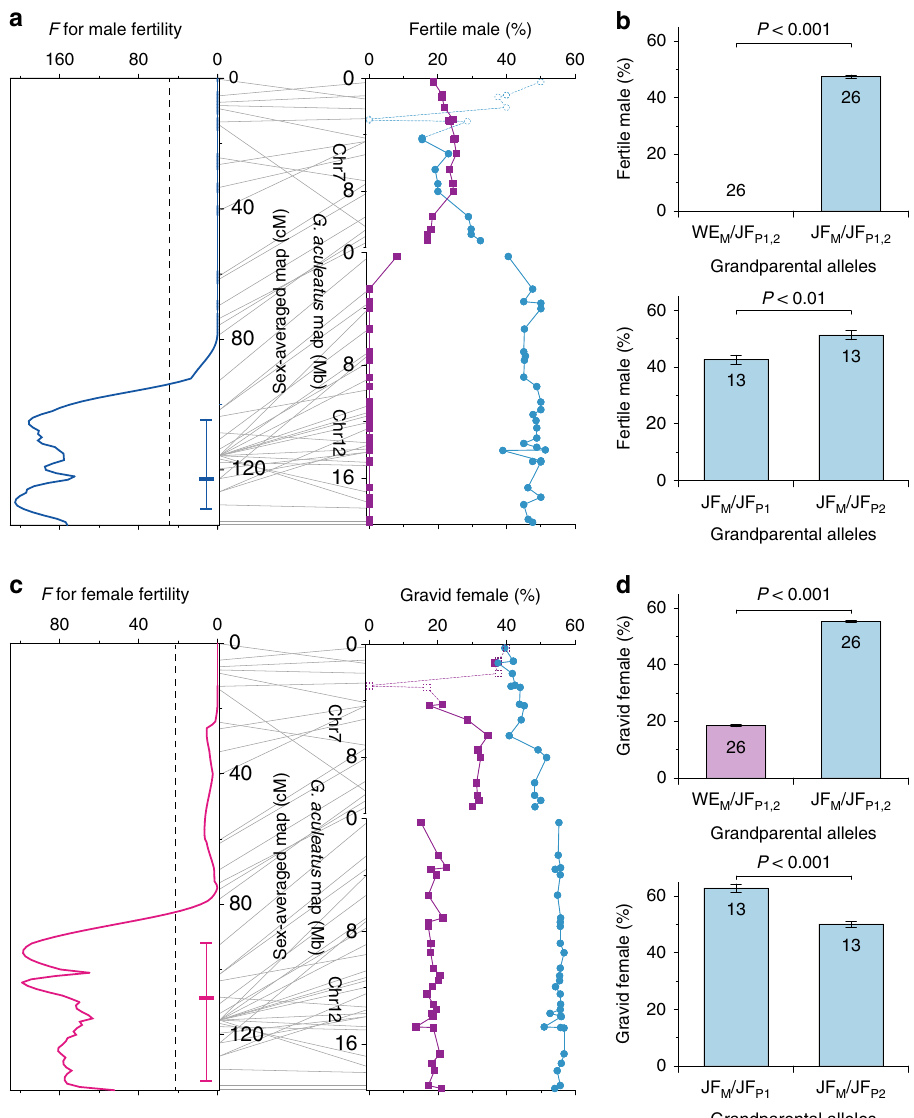
Fig. 5 QTL region for hybrid male and female fertility. a QTL analyses for male fertility (left) and the proportions of fertile males with different allelic combinations at each locus (right) in the backcross. b The proportions of fertile males with different allelic combinations in the inversion region (3.5 – 18.9 Mb of G. aculeatus Chr12). c QTL analyses for female fertility (left) and the proportions of gravid females with different allelic combinations at each locus (right) in the backcross. d The proportions of gravid females with different allelic combinations in the inversion region. In a , c , dashed lines in the graphs on the left represent statistically signi fi cant levels ( P = 0.05) of the F -value. The mean and 95% con fi dence interval of a QTL position are indicated to the left of the map positions. In the graphs on the right, data for individuals with both WE and JF alleles at each locus are indicated in purple and those with only JF alleles are indicated in cyan. Open symbols represent data from ≤ 10 individuals due to the presence of sex-linked alleles. In b , d , means and standard errors for loci with grandparental WE and JF alleles (WE M /JF P1,2 ) and those with two grandparental JF alleles (JF M /JF P1,2 ) are shown on the top. Means and standard errors for loci with two JF alleles, one from the maternal grandmother (JF M ) and the other from the paternal grandmother (JF P1 ) or grandfather (JF P2 ), are shown at the bottom. Data for individuals with both WE and JF alleles are indicated in purple and those with only JF alleles are indicated in cyan. Numbers of loci analyzed are indicated in the without eggs), is found in the region of 108.4 cM (95% con fi dence interval, 92.0 – 135.0 cM) in the sex-averaged map ( F = 99.1, P < 0.01; Fig. 5c), which corresponds to the QTL region of male fertility. The proportion of gravid females is 18.5% in individuals heterozygous for both grandparental WE and JF alleles in the inversion region, whereas it is 55.3% in individuals homozygous for JF alleles (Mann – Whitney U test, P < 0.001; Fig. 5d). In the latter group, individuals with alleles from the paternal grand- mother show a higher proportion of gravid females (62.8%) than those with alleles from the paternal grandfather (50.0%;